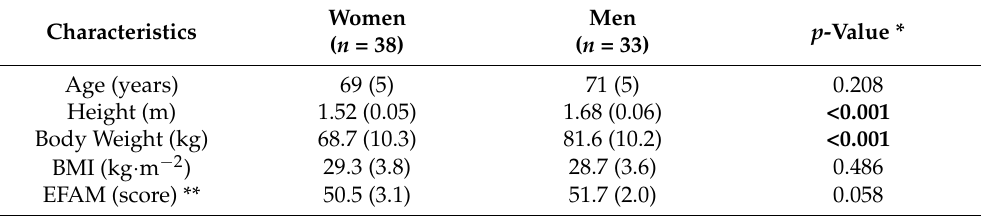
Table 1. Characteristics of the participants are distributed by sex. Data are presented as mean (standard deviation).